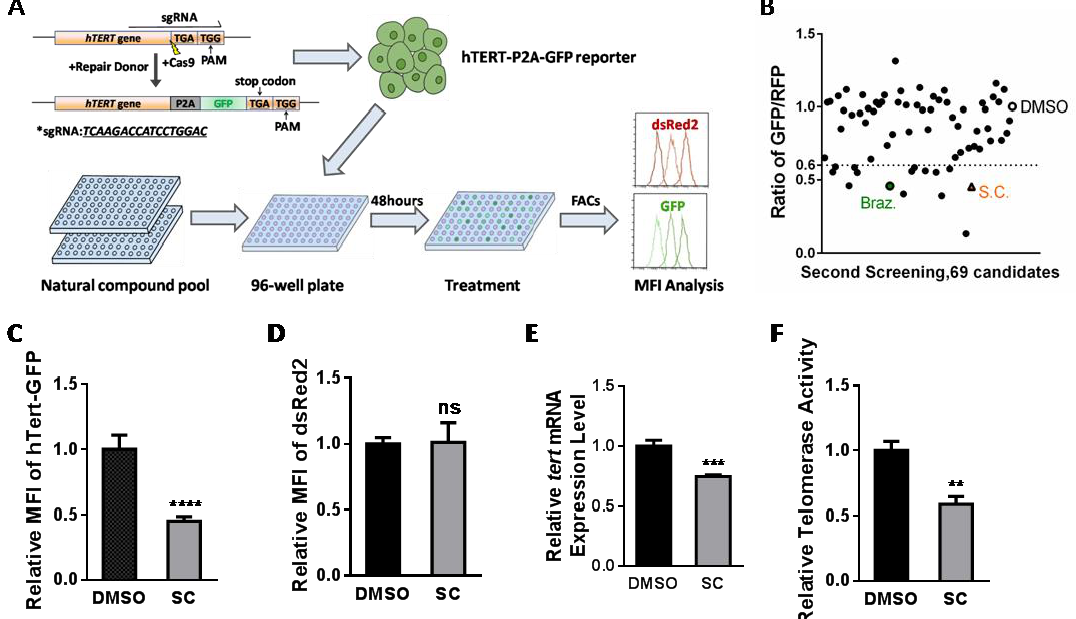
Figure 1. Screening of natural hTERT inhibitors and their verification in the endogenous hTERT-P2A-GFP knock-in HEK293Treporter cell line. ( A ) Schematics of the endogenous hTERT-P2A-GFP HEK293T reporter cell line construction and the screening strategy of a natural product pool for telomerase modulators. Two rounds of screening were carried out and com- pounds with GFP/RFP ratio ≤0.6 were selected as candidates. ( B ) Results from the second round of compound screening, with two candidates highlighted as potential inhibitors. The orange triangle indicates SC while the green rectangle indicates Braz. ( C , D ) Mean fluorescence intensity (MFI) quantification of endogenous hTERT-GFP ( C ) and internal reference dsRed2 ( D ) after 1 μM SC treatment for 48 h. ( E ) hTERT mRNA level by quantitative real-time PCR of reporter cell line upon the treatment of SC (1 μM) for 24 h. DMSO served as the control group. ( F ) Real-time quantitative telomeric repeat amplification protocol (Q- TRAP) assay in reporter cells treated with SC (1 μM). DMSO served as the control group. The screening was performed three independent times. Re-